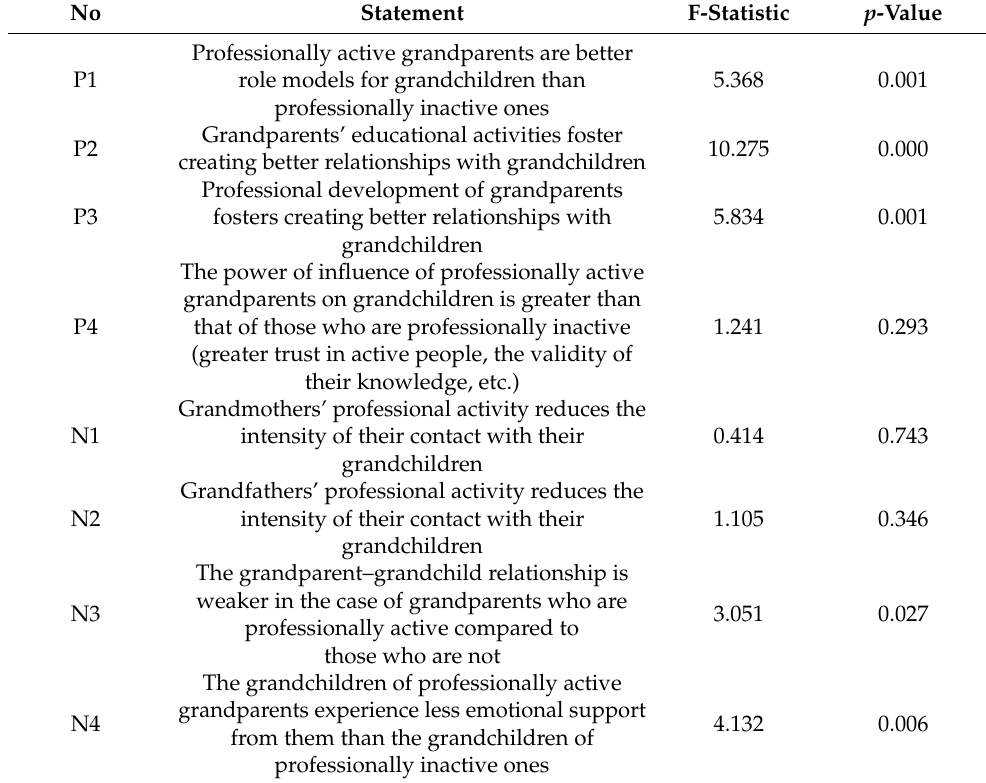
Table 3. Results of ANOVA for the grouping variable